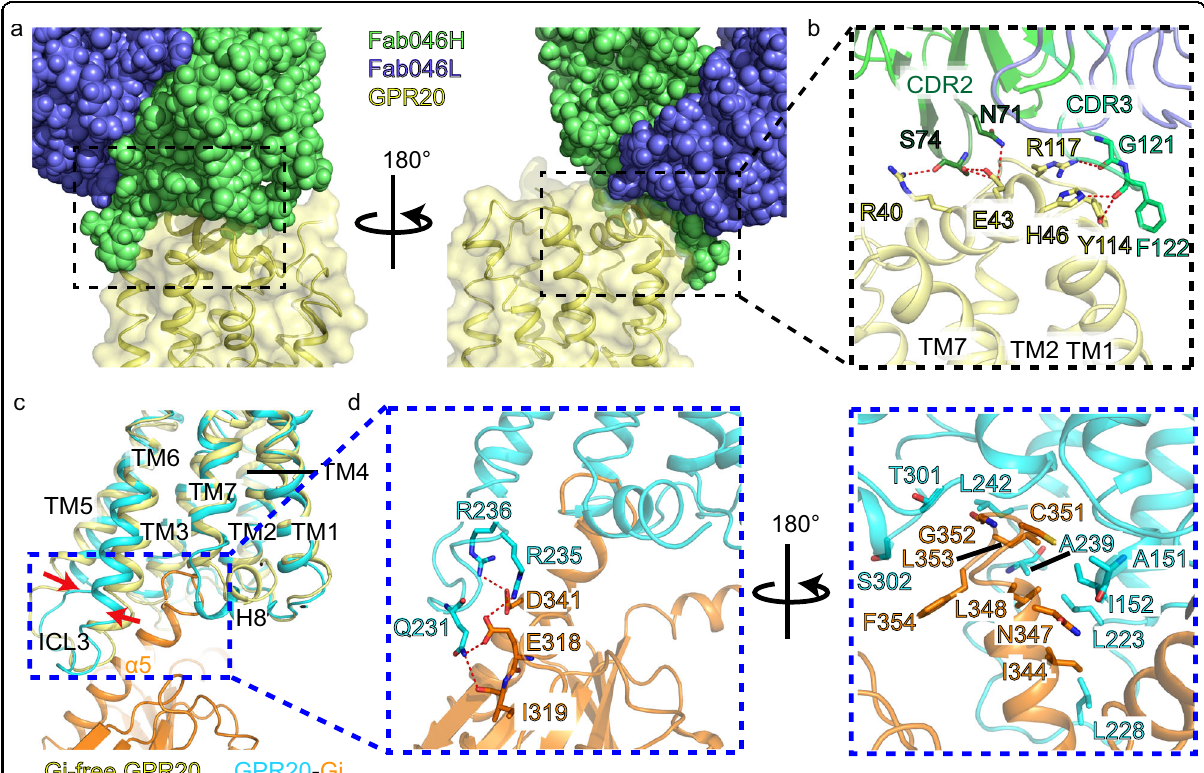
Fig. 5 Binding interfaces for the Fab046 antibody and Gi protein on GPR20. a The binding interface between Fab046 (heavy chain in green, light chain in purple, spheres) and GPR20 (yellow, ribbon and transparent surface) is shown in two different views. b Magni fi ed view of the antibody binding interface. CRD2 is shown in dark green, CDR3 is shown in light green, key residues are shown as sticks, and polar interactions are highlighted as red dashed lines. c The Gi binding interface. d Polar interactions (left) and hydrophobic interactions (right) between GPR20 (cyan) and Gi protein (orange). Key residues are shown as sticks, and polar interactions are highlighted as red dashed